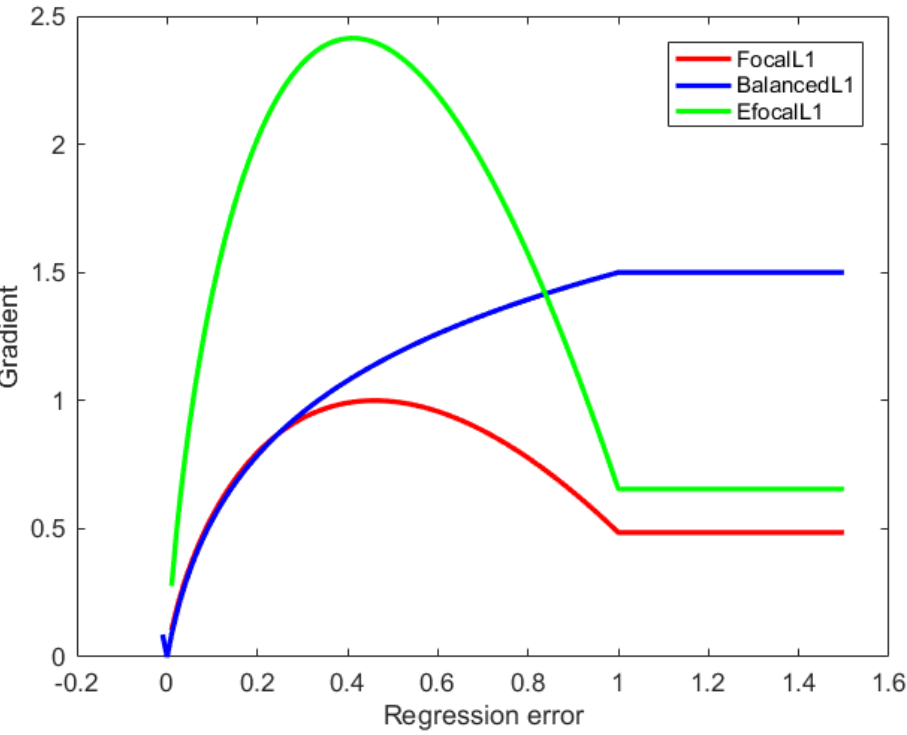
Figure 6. Curves for the gradient of FocalL1 loss, BalancedL1 loss, and our EFocalL1 loss for BBR.